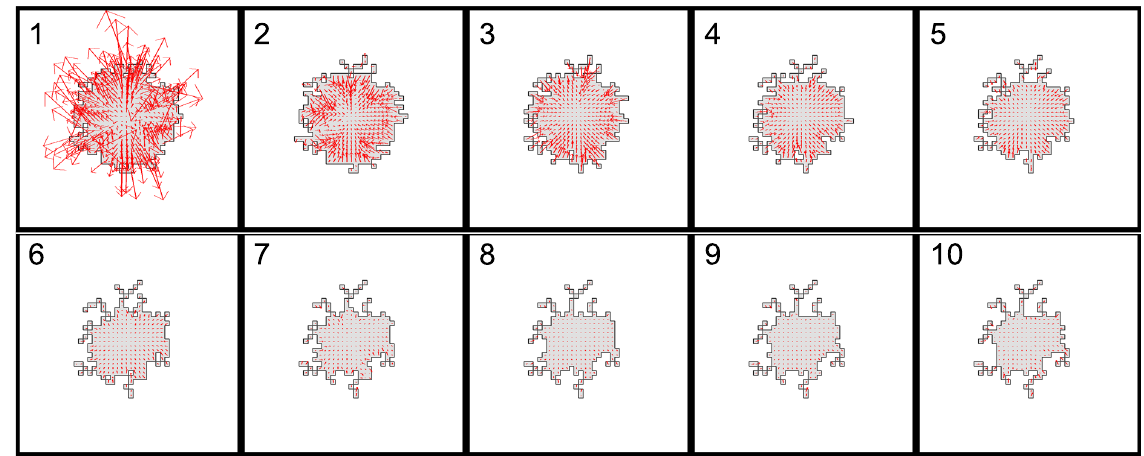
Fig 3. Dynamics of cell shape and the evolution of forces. Time series from 1 to 10 MCS. The cell achieves force balance by decreasing its area towards the rest area a and increasing its perimeter towards the rest perimeter p . Parameters were a = 200, λ = 8, p = 100, λ p = 2000, J (0, 1) = 3000, T = 10. The sequence of cell areas A at each of the above Monte Carlo steps decrease as follows: A = 397, 364, 332, 299, 280, 250, 232, 219, 213, 208, and the sequence of cell perimeters first increases and then fluctuates: P = 74, 94.8, 98.2, 100.1, 99, 99.2, 99.1, 98.9, 99,